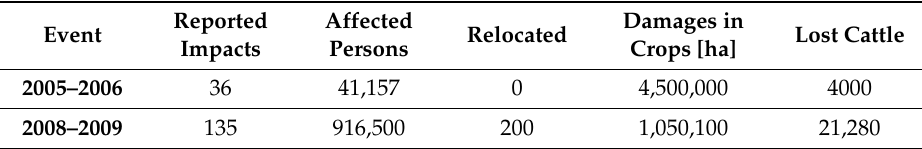
Table 2. Reported impacts, persons affected and relocated, damages in crops (ha.) and cattle lost during the 2005–2006 and 2008–2009 droughts (Source: Desinventar;